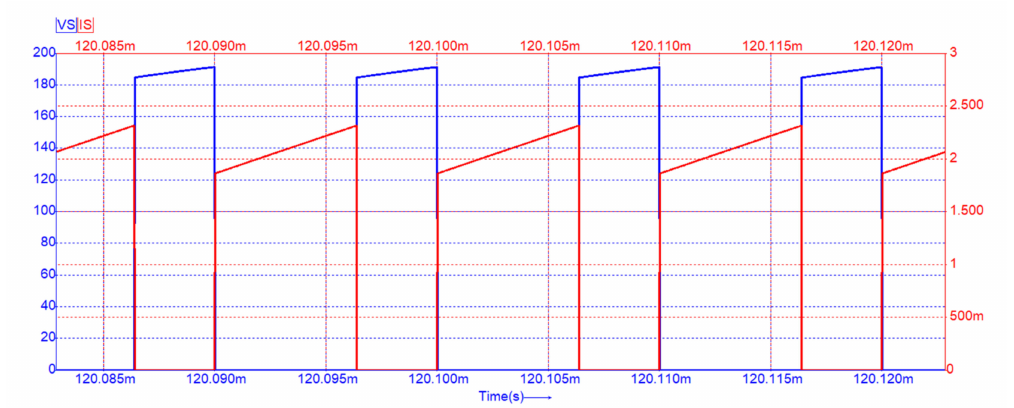
Figure 15. Voltage and current corresponding to the transistor S .